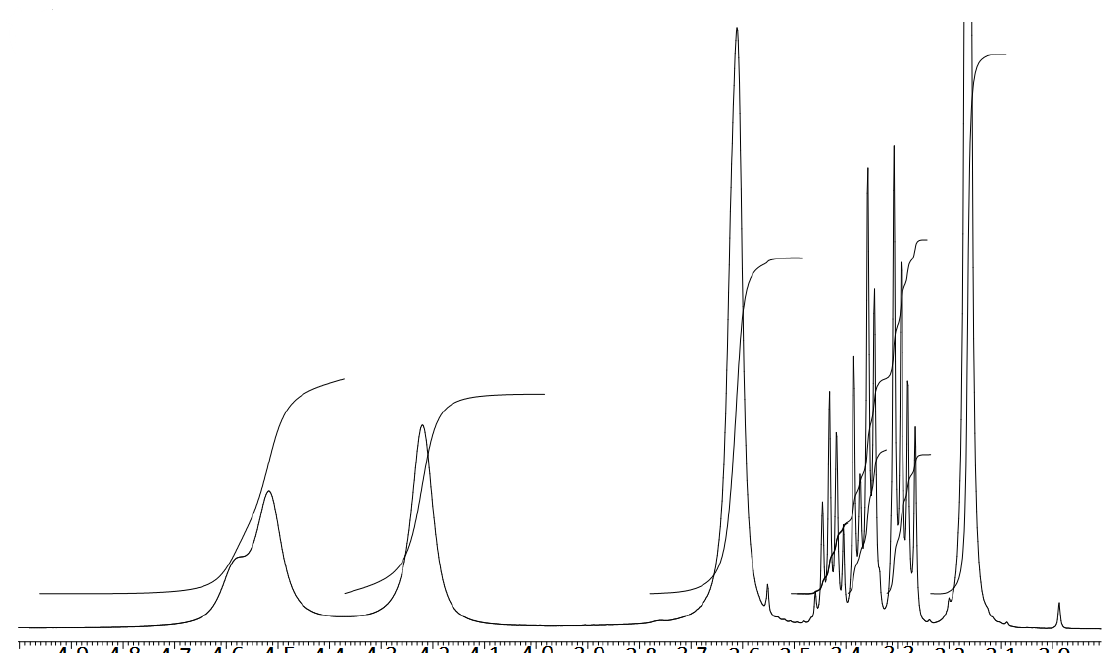
Figure 18. 1 H-NMR spectrum of phase-separated raw glycerol in D 2 O.